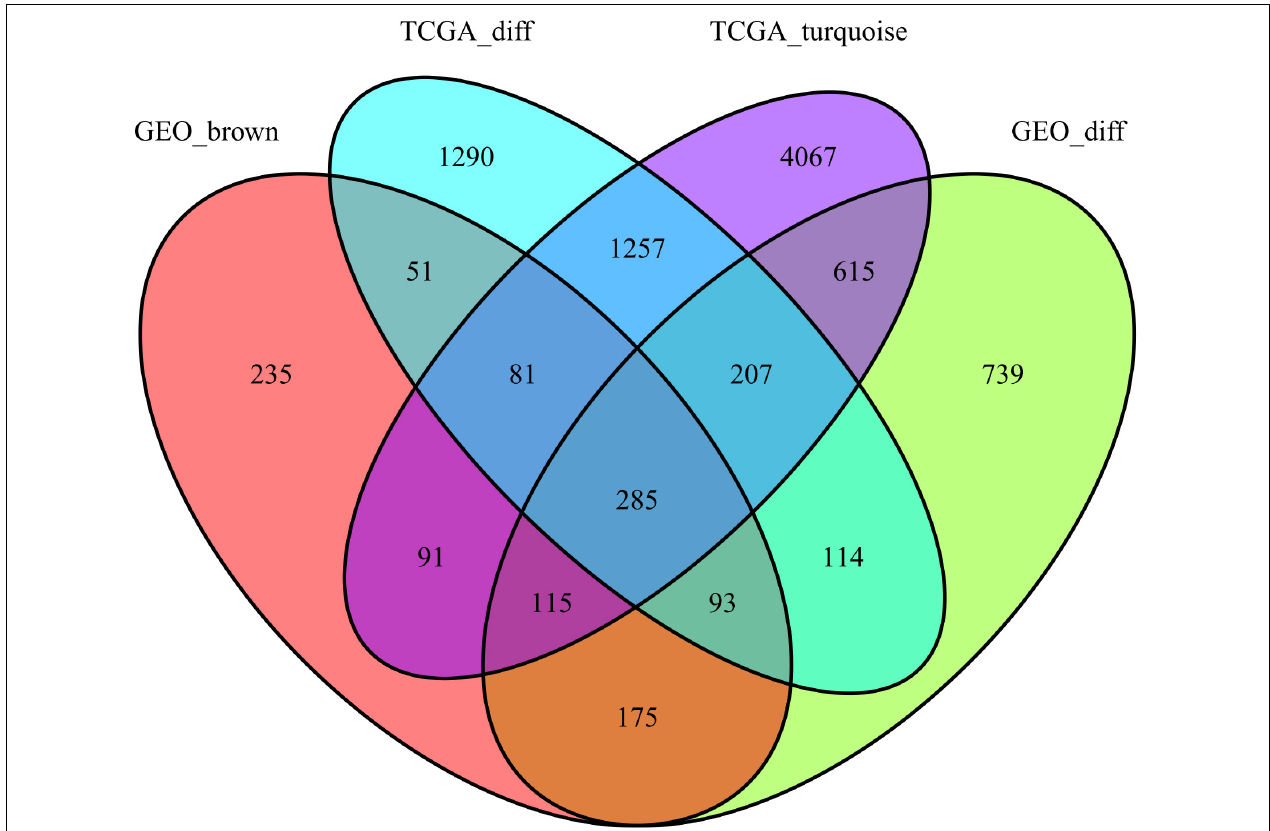
FIGURE 4 | Gene Venn diagrams between the two groups of DEGs and the two groups of co-expressed genes.